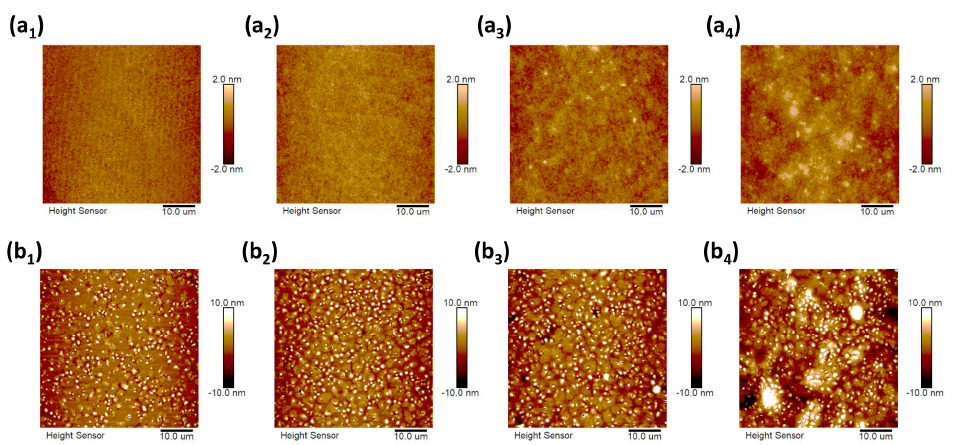
Figure 4. ( a 1 – a 4 ) AFM images of the PVA films spun from different concentrations (3 wt %, 6 wt %, 8 wt %, and 10 wt %). ( b 1 – b 4 ) AFM images of the C8-BTBT films on the corresponding PVA films in ( a 1 – a 4 ).